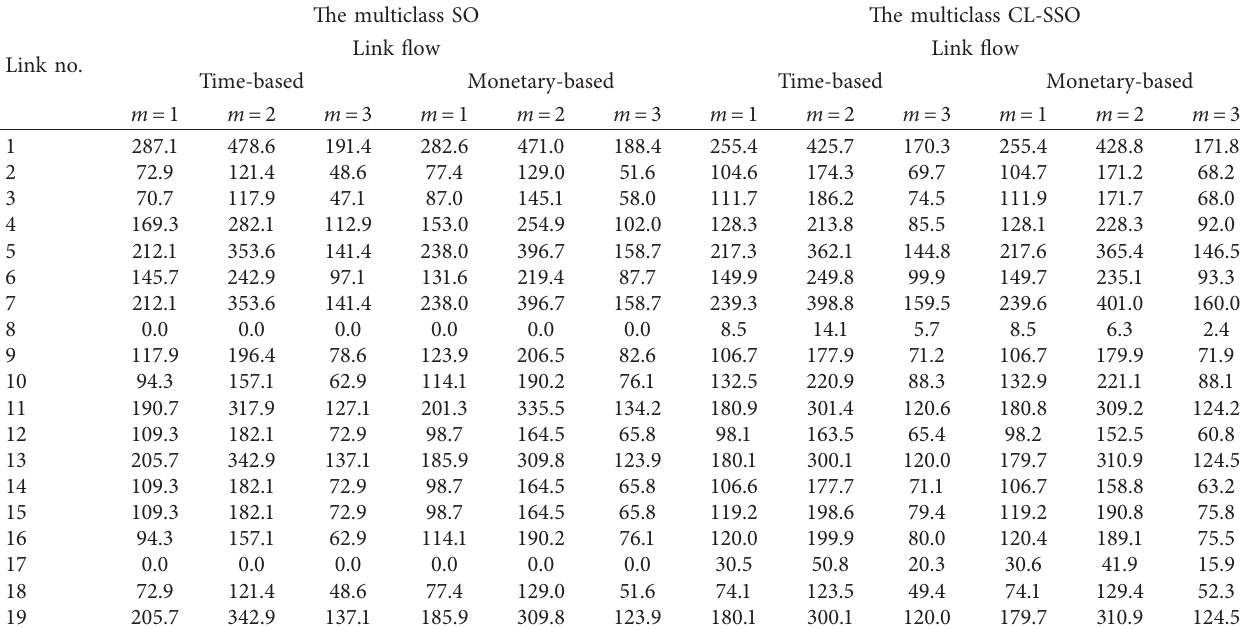
Table 8: Link results of the multiclass SO and CL-SSO models.